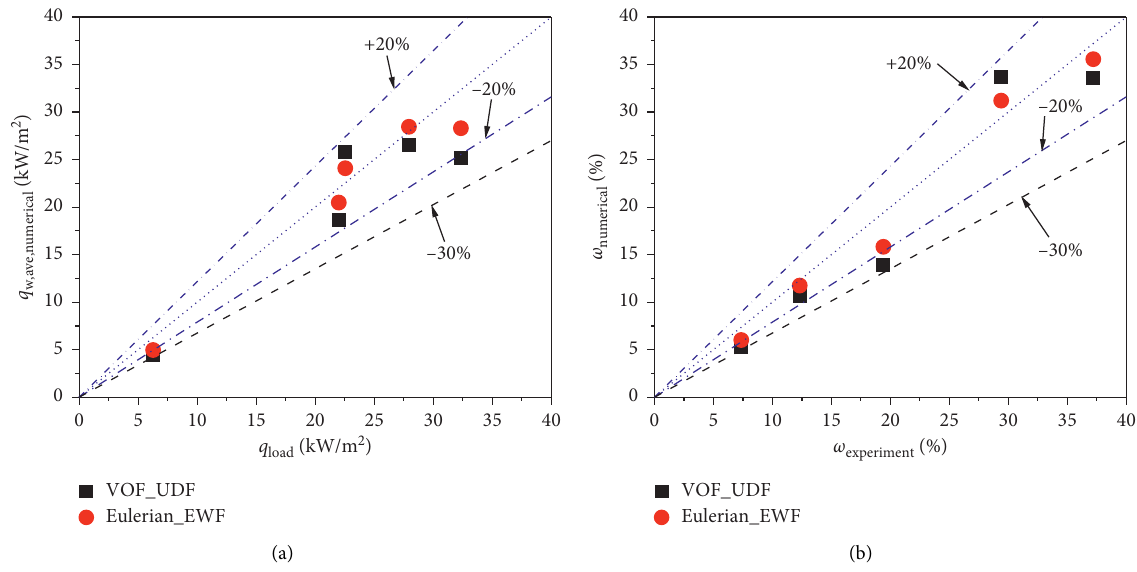
Figure 5: Comparison of the average bottom plate surface heat flux and the water film evaporation mass flow ratio obtained from the experiment and numerical